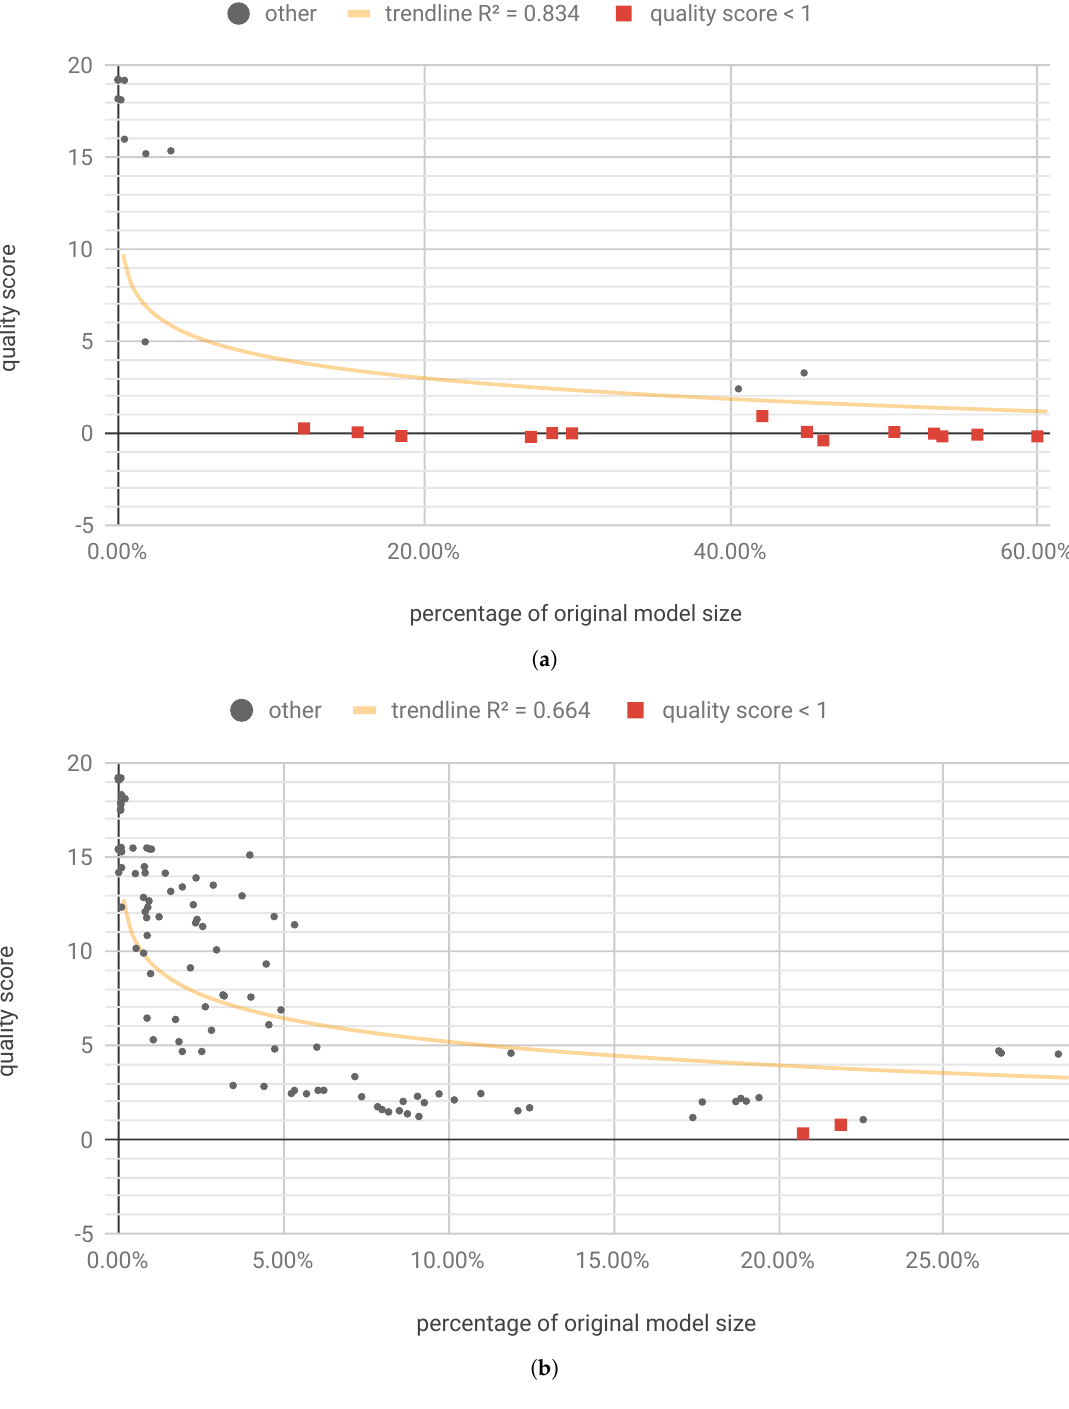
Figure 12. [LHC] Unique first Pareto front results for model trained on continuous data. ( a ) Flow A: per-model pruning and quantization. trendline ( x ) = 0.364 − 1.63ln x ; ( b ) flow B: individualized pruning and quantization. trendline ( x ) = 1.02 − 1.81ln x